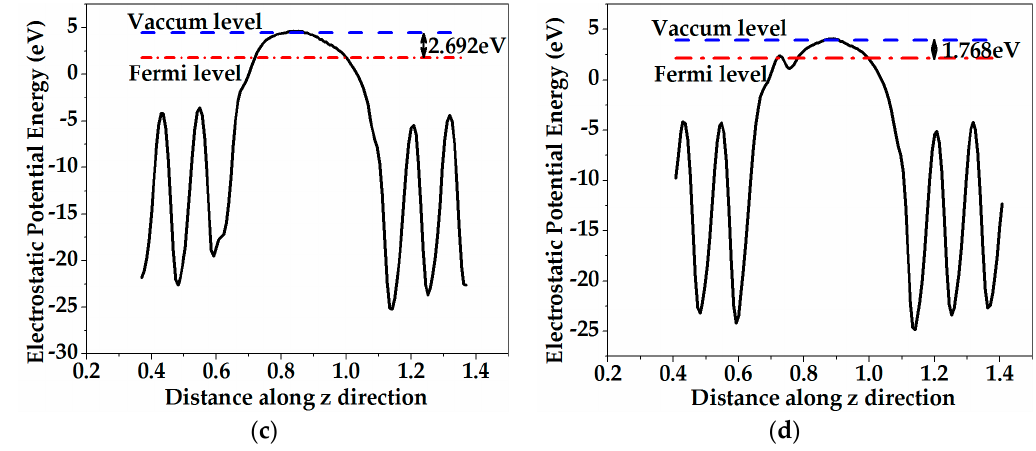
Figure 6. Calculated electrostatic potential of the z direction for ( a ) the pristine ZnO (0001) surface and the iron atom adsorbed on ( b ) the H 3 site, ( c ) the T 4 site, and ( d ) the Top site of the ZnO (0001) surface.